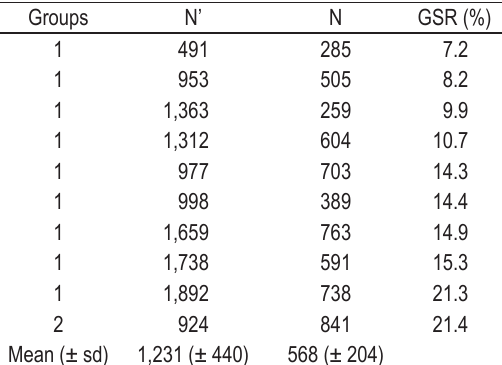
Table 2. Ovaries groups (according to oocytes diameters distribution), oocytes from initial ripening phase (N’), ripe oocytes (N) and values of gonadosomatic relation (GSR) of Serrapinnus heterodon from Mogi Guaçu reservoir.